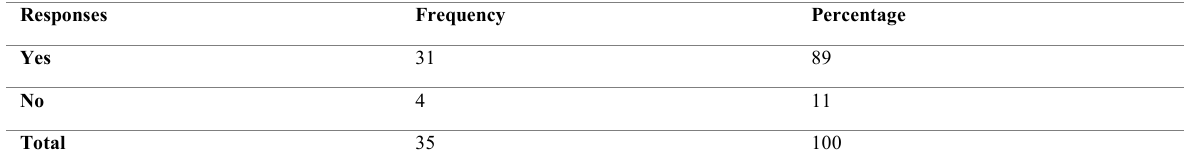
Table 1: Distribution of responses based on the presence of